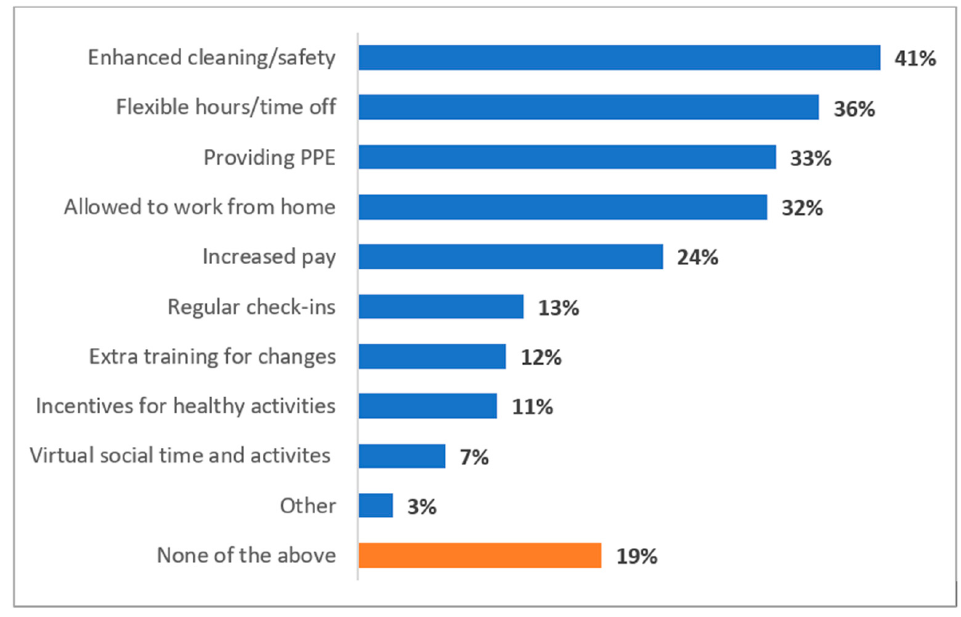
Figure 10. Industry support during COVID-19 pandemic ( n = 146).